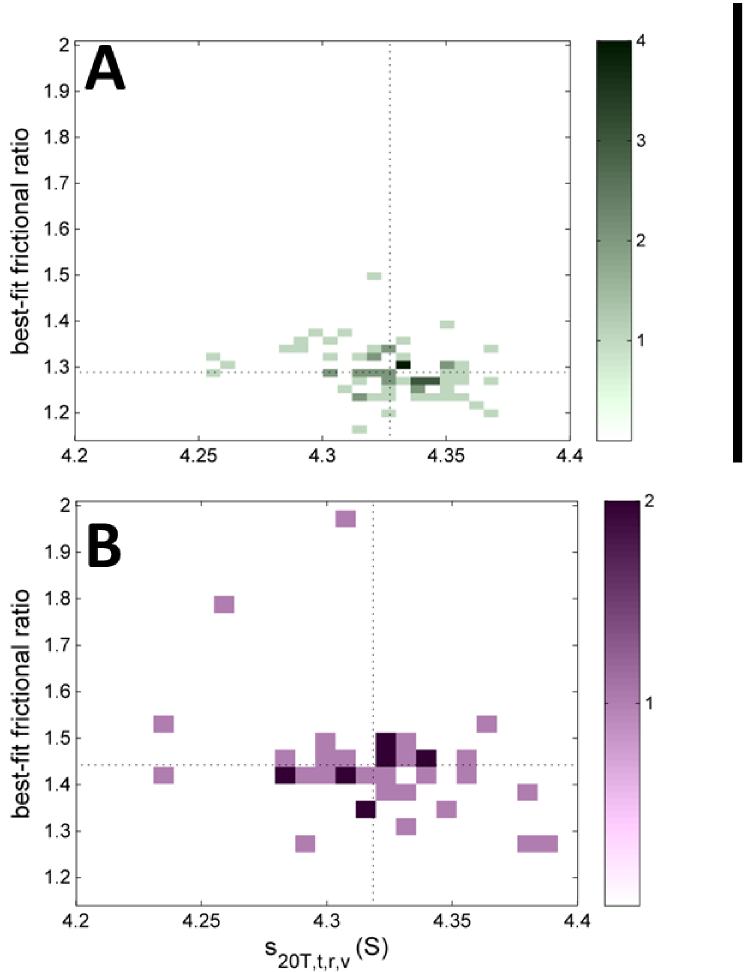
Fig 14. Correlation between the best-fit frictional ratio from the c ( s ) analysis and the final s 20T , t , r , v - value for the absorbance system (A) and interference system (B). Data are shown as a histograms with frequency values indicated in the colorbars. The dotted lines indicate the average frictional ratio and s 20T , t , r , v - values of both systems, respectively. To aid the comparison, both histograms are plotted in the same scale.